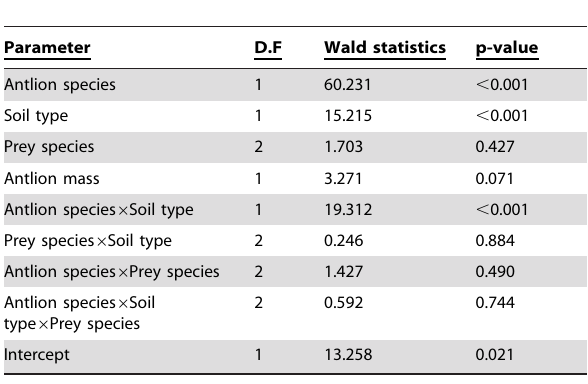
Table 2. Logistic regression analysis testing for differences in prey capture success of antlions encountering different prey ant